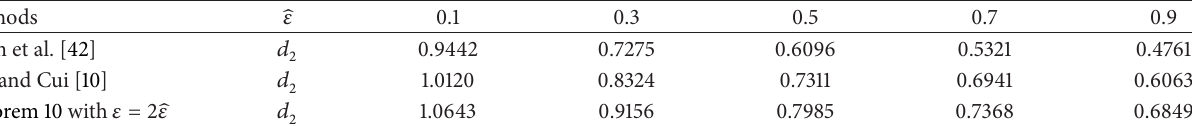
Table 4: Maximum upper bound of 𝑑 2 with different 𝜀 and parameter 𝜇 = 0.5 .